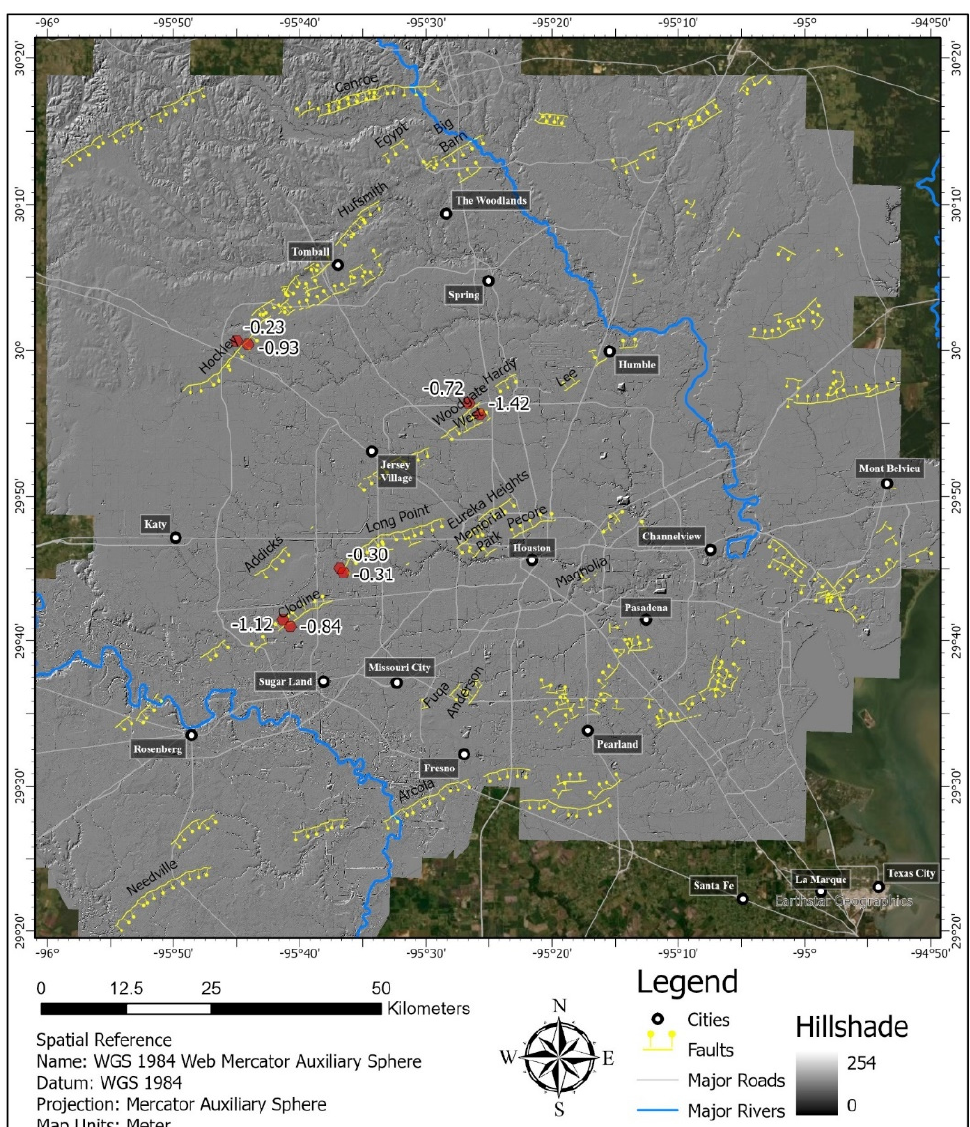
Figure 7. Updated fault map of Houston and surrounding areas. Three major fault systems run southwest to northeast; in the southeast, faults are associated with the salt domes. The background hillshade image was generated from lidar data.